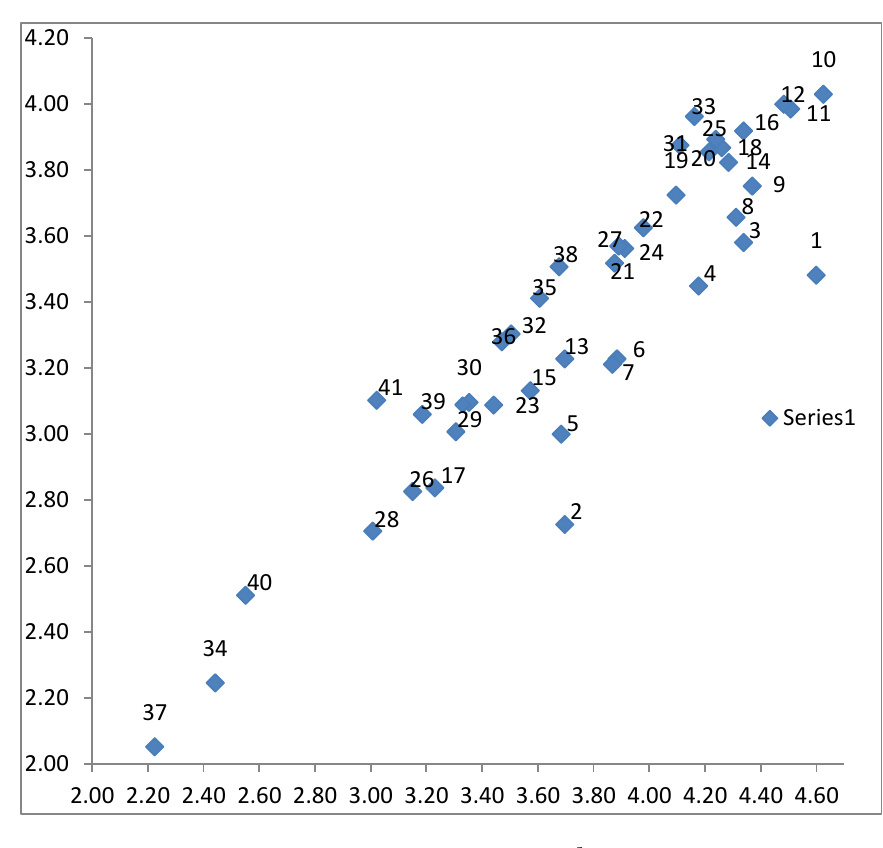
Figure 1. Importance-Competency Analysis. This figure illustrates the most important training gaps of distance educators by comparing the importance of certain work roles with educators’ current